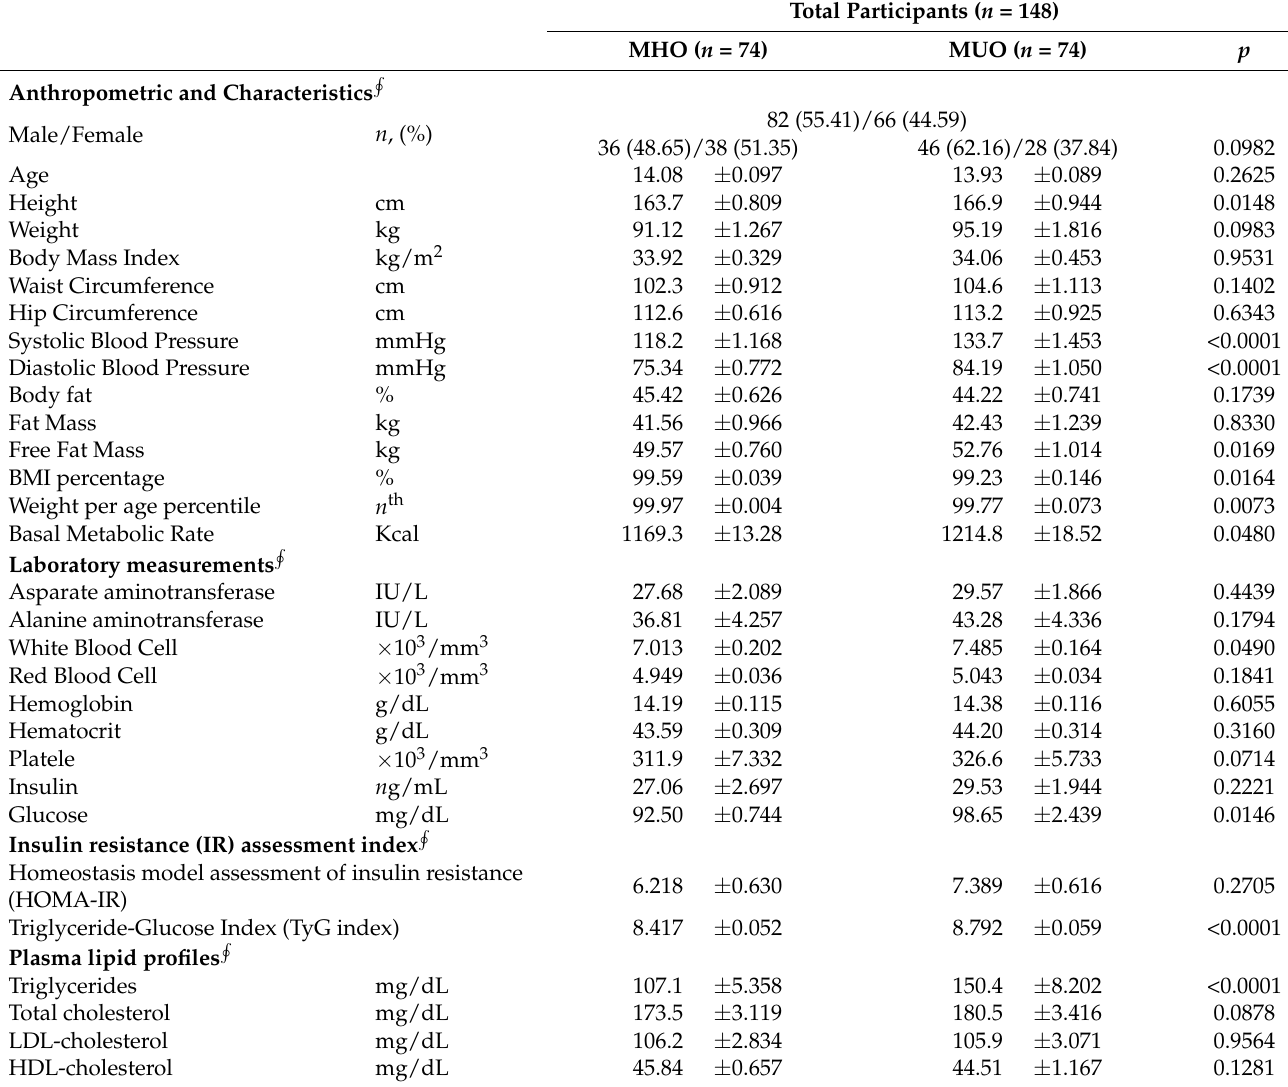
Table 1. Anthropometric parameters, characteristics, laboratory measurements, IR assessment index, and plasma lipid profiles of MUO and MHO in